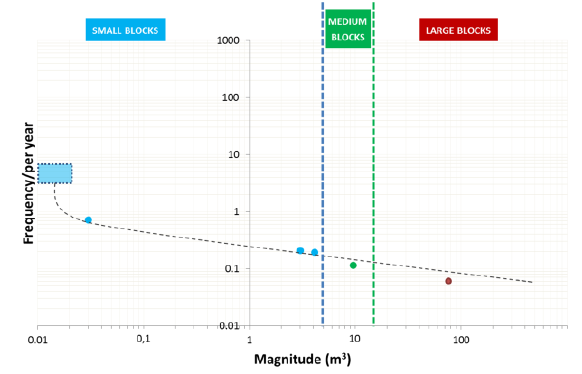
Figure 2. Relationship between magnitude and frequency of instability phenomena of rock slope failures (points) and